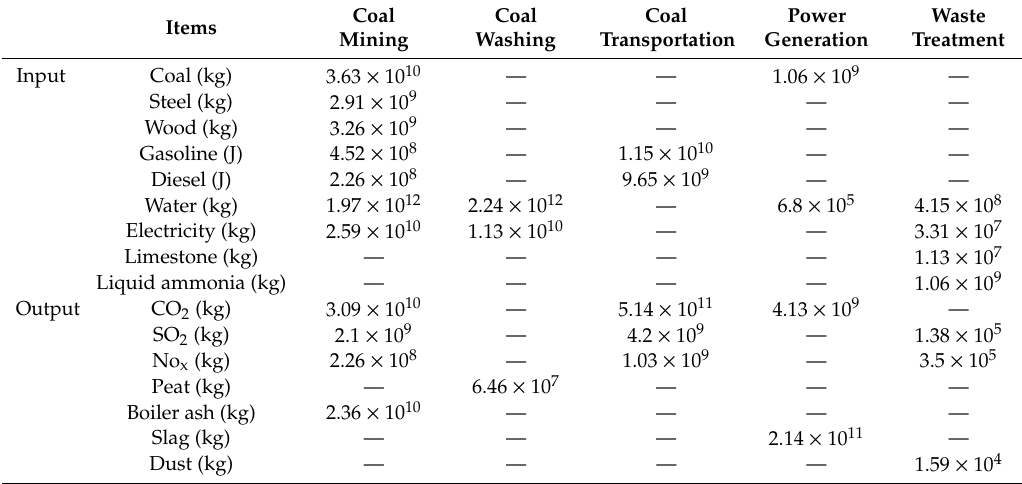
Table 2. Life cycle inventory of a 600 MW coal-fired generating unit (Unit 2). Items